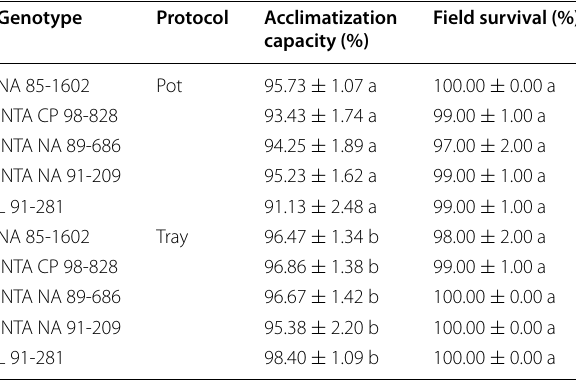
Means followed by the same letter do not differ according to the DGC test ( P < 0.05)